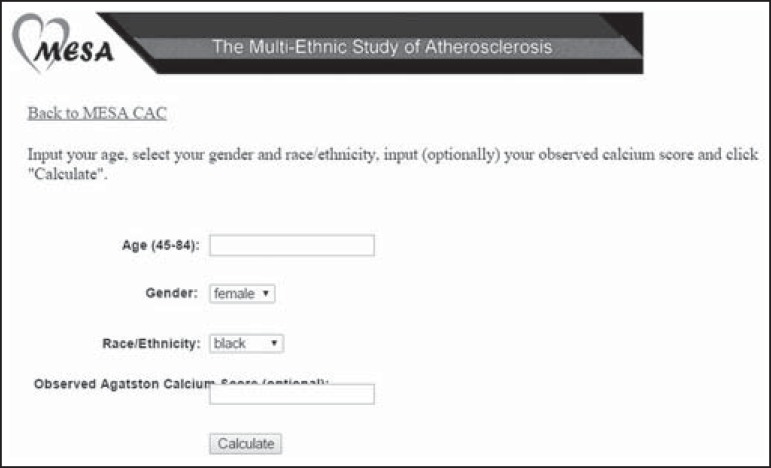
Tool for calculating the CAC score in percentiles, according to the
distribution by age, gender, and ethnicity, as per the MESA.